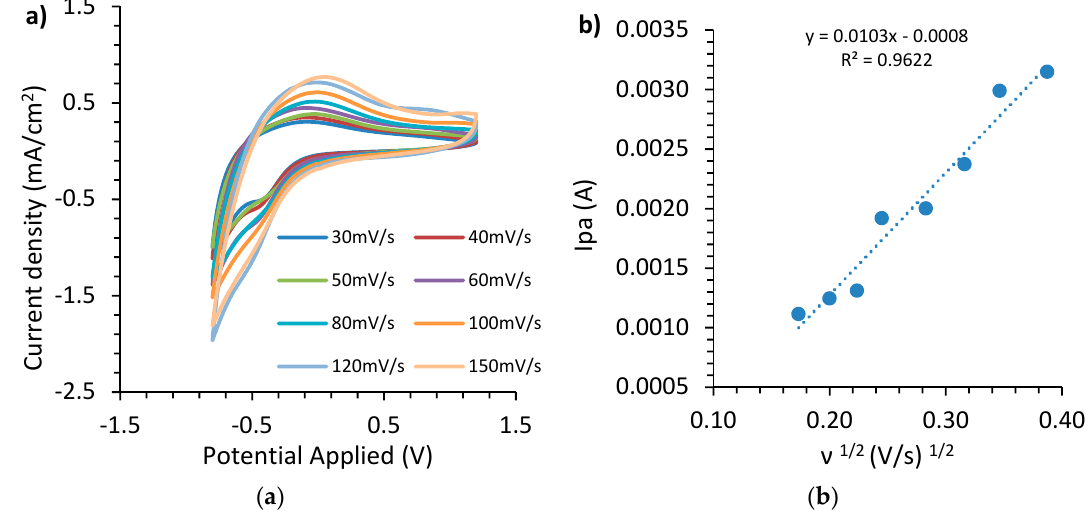
Figure 5. ( a ) WO 3 cyclic voltammetry curves at various scan rates, ( b ) plot of anodic peak current versus the square root of the scan rate.